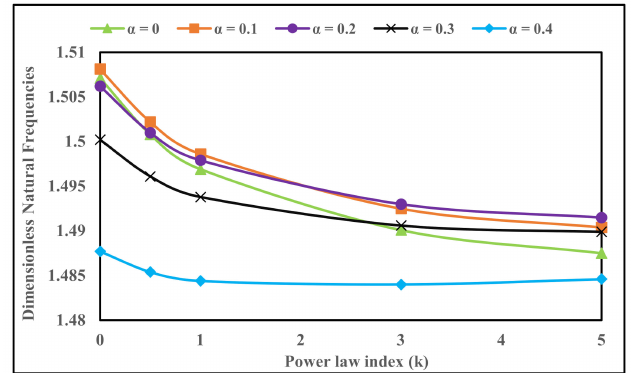
Figure 8. Variation in DNF for di ff erent power law indices